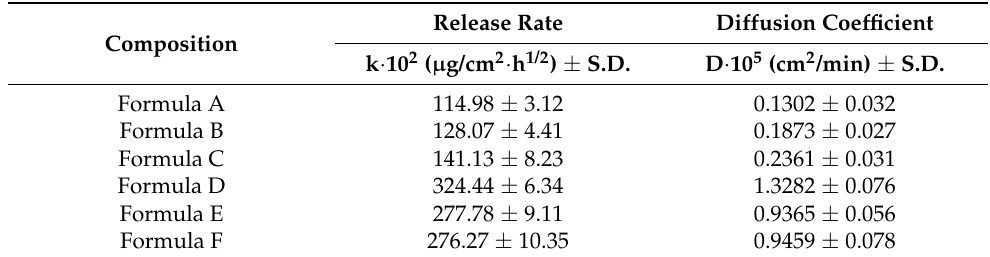
Table 3. Diclofenac sodium release rate and the diffusion coefficient values related to the formulations A-F. Each data point represents the mean ± S.D., n = 6.